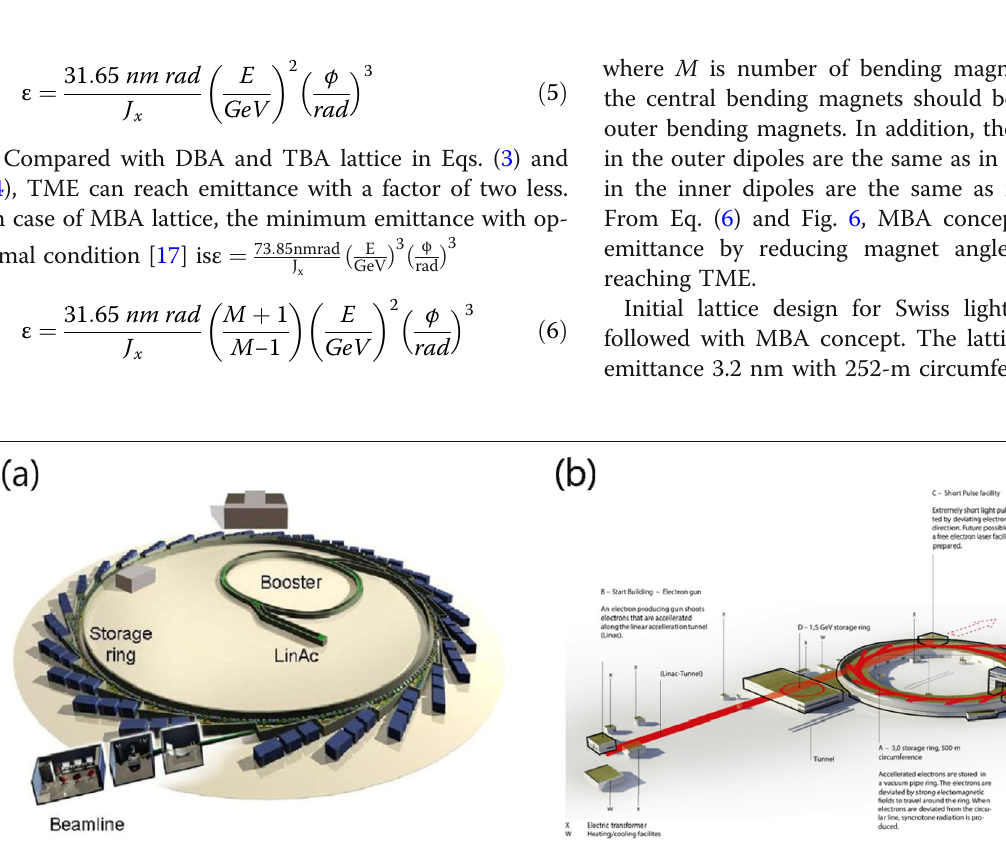
Fig. 4 Injector system for 3GSR. a Booster. b Linear